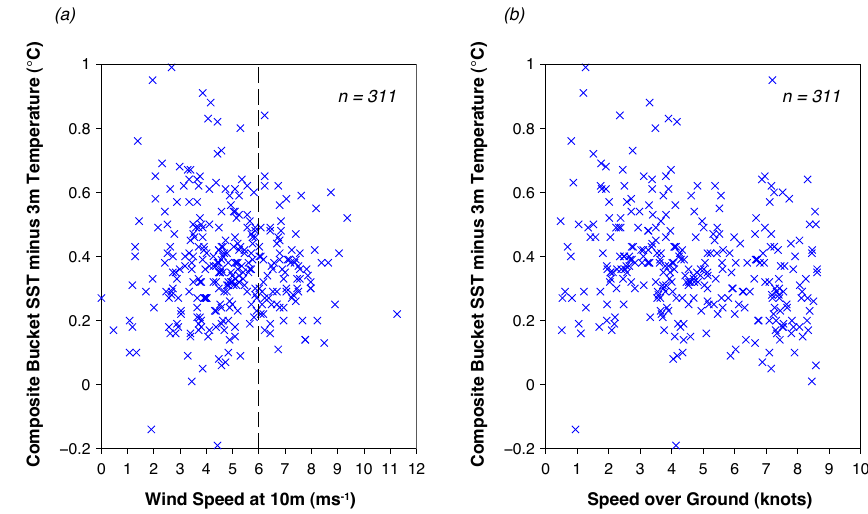
Fig. 8. Scatter plots comparing upper 3m temperature differences with (a) true wind speed at 10m and (b) speed over ground of the Seamans . A linear least squares regression for plot (b) yields a sizeable negative gradient of − 0.02, although with r 2 = 0 . 06. The vertical dashed line on (a) denotes a wind speed of 6ms − 1 . General thinking holds that the near-surface should be near-isothermal at higher wind speeds.